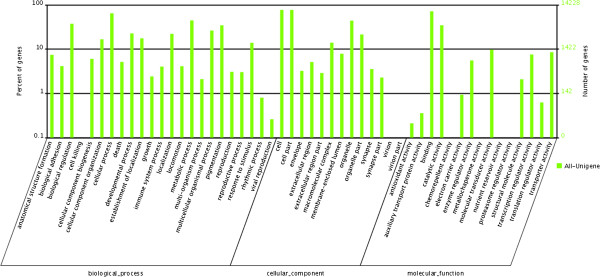
Functional annotation of mandarin fish transcripts based on GO categorization. The left y-axis indicates the percentage of a specific category of genes in that main category. The right y-axis indicates the number of genes in a category.